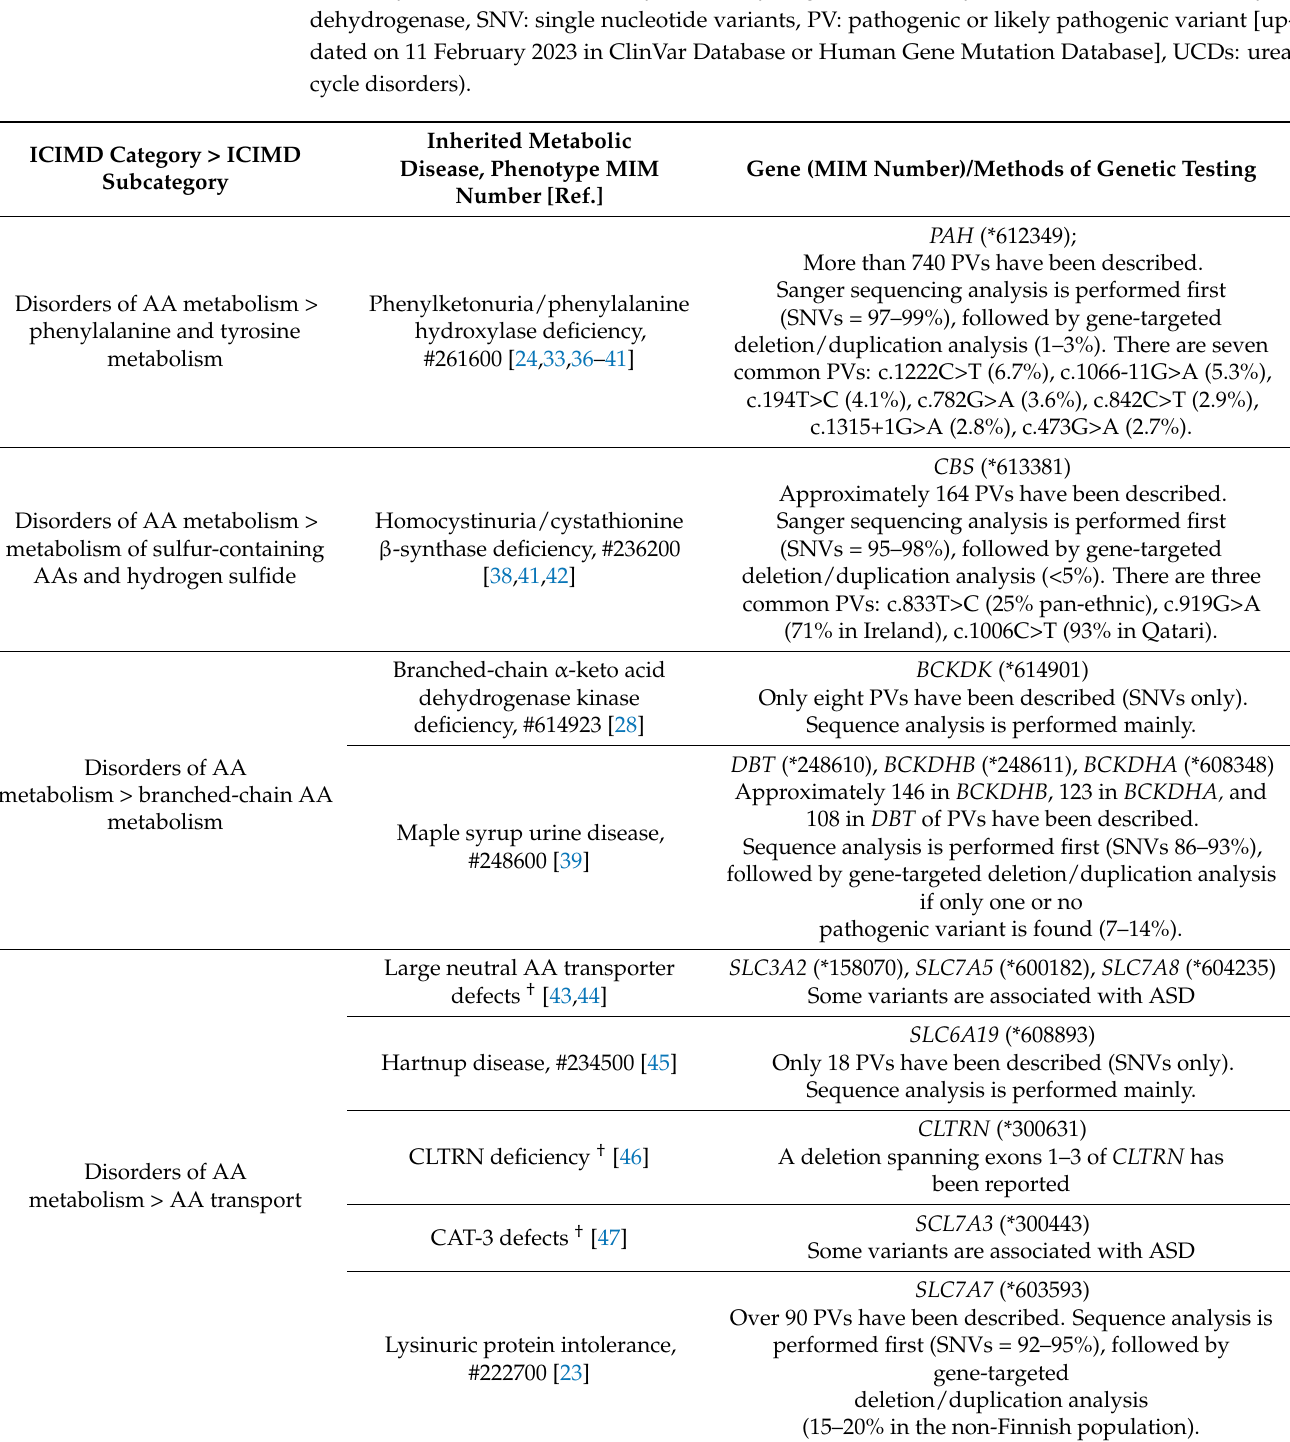
Table 1. Inherited metabolic diseases associated with autism spectrum disorder (ASD). All variants were annotated according to the MANE Select transcript. † Disorders with no MIM numbers (AA: amino acid, ADSL: adenylosuccinate lyase, ASLD: argininosuccinate lyase deficiency, CAT-3: cationic amino acid transporter-3, CLTRN: collectrin, CNV: copy number variation, CPS1D: carbamoyl